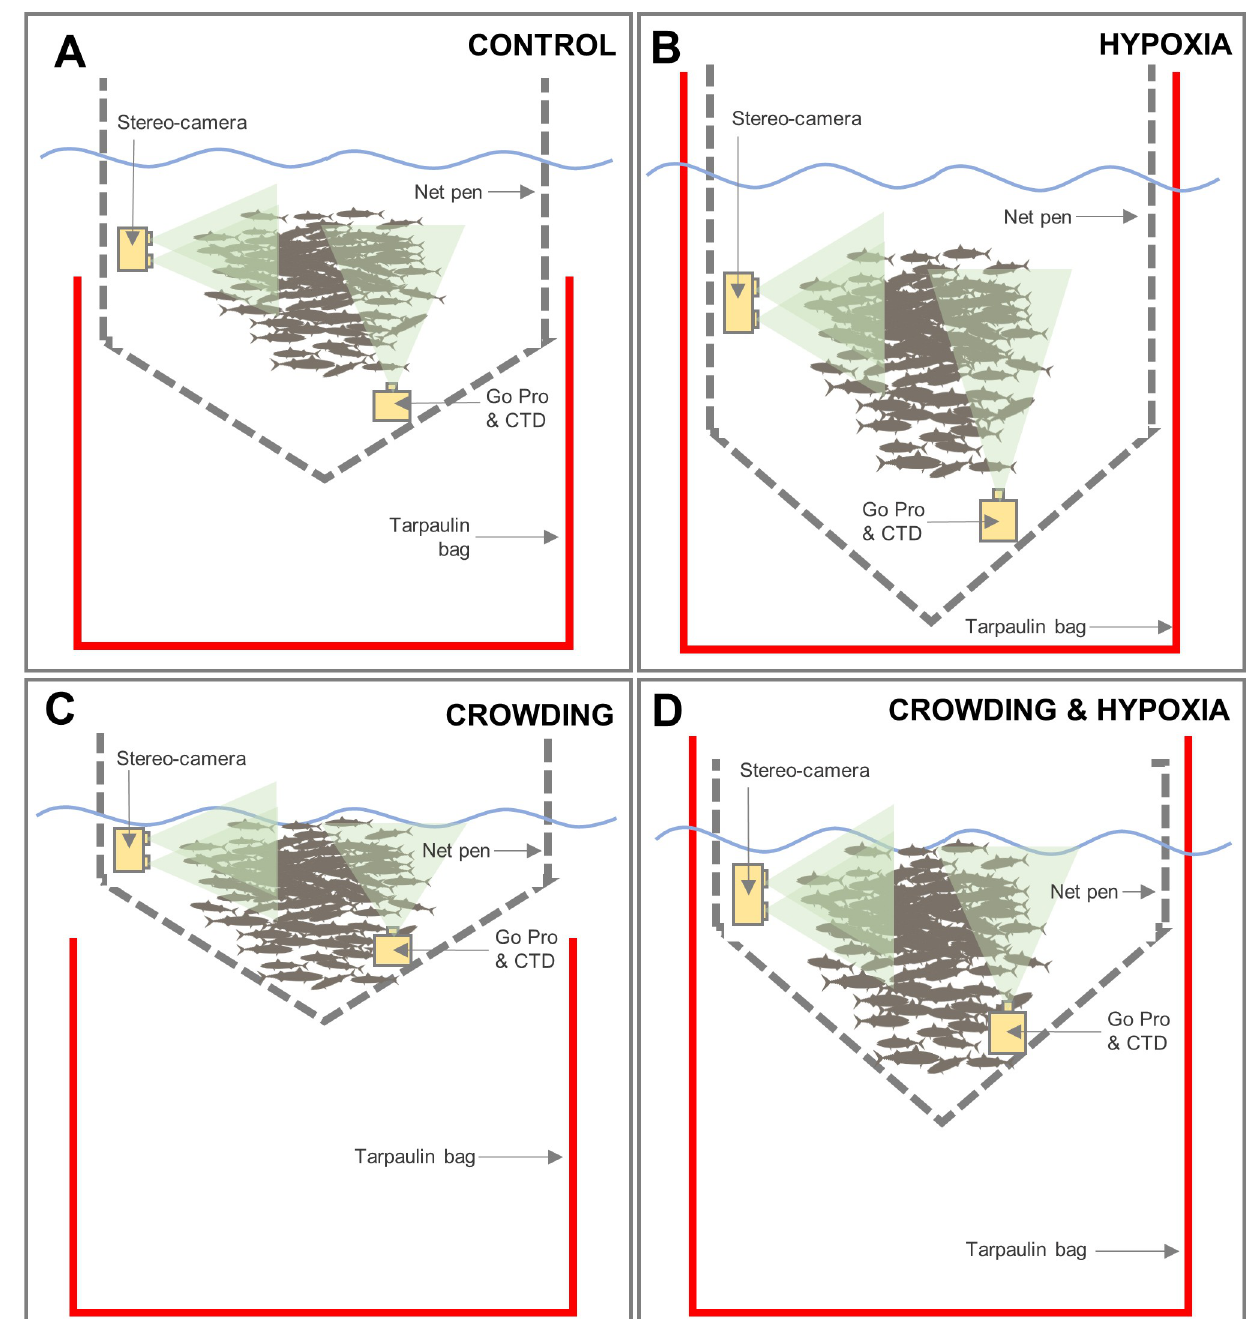
Fig 1. Schematic of the experimental set up. Showing a vertical cross-section of net pens (not to scale) for the different stressor treatments of: A : “control”; B : “hypoxia”; C : “crowding” and D : “crowding & hypoxia”. The waters surface is indicated by the wavy blue line. Shaded green areas represent the approximate viewing direction of the